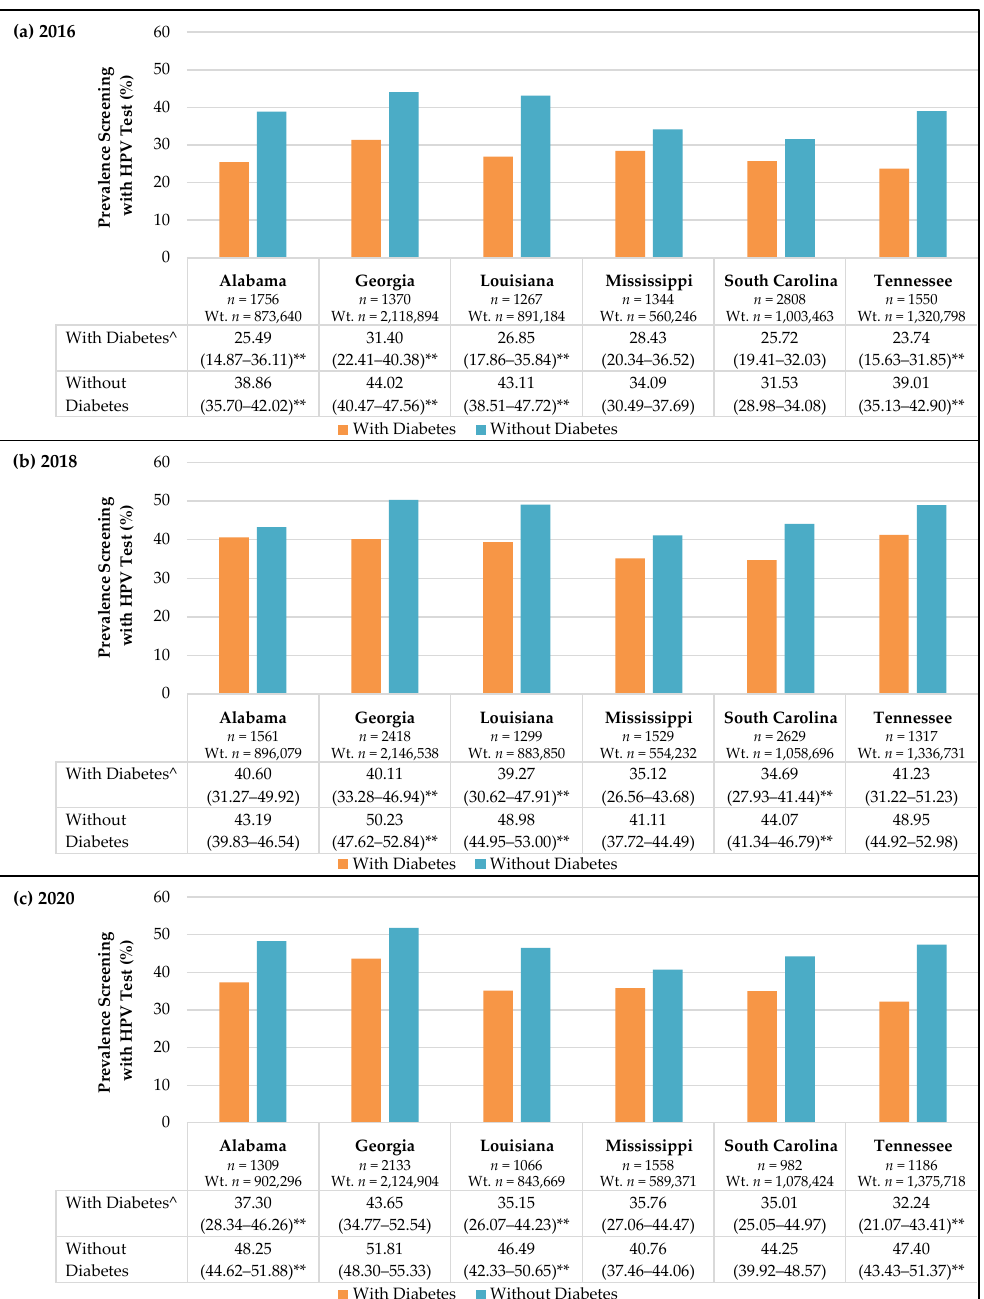
Figure 2. HPV Testing Behaviors of Females with and without Diabetes among States in the Deep South in ( a ) 2016, ( b ) 2018, and ( c ) 2020. Weighted percentages (Weighted % (95% CI)) are presented for females who self-reported screening for cervical cancer with HPV test; age parameters follow the American Cancer Society’s guidelines for screening. Wt. n = weighted sample size. ^ Use caution when interpreting prevalence estimates within this sub-group; unweighted frequency < 50 or 95% confidence interval width > 10. ** p < 0.05; chi-square tests detected significant differences in prevalence screening with HPV test between females with and without diabetes in this state.